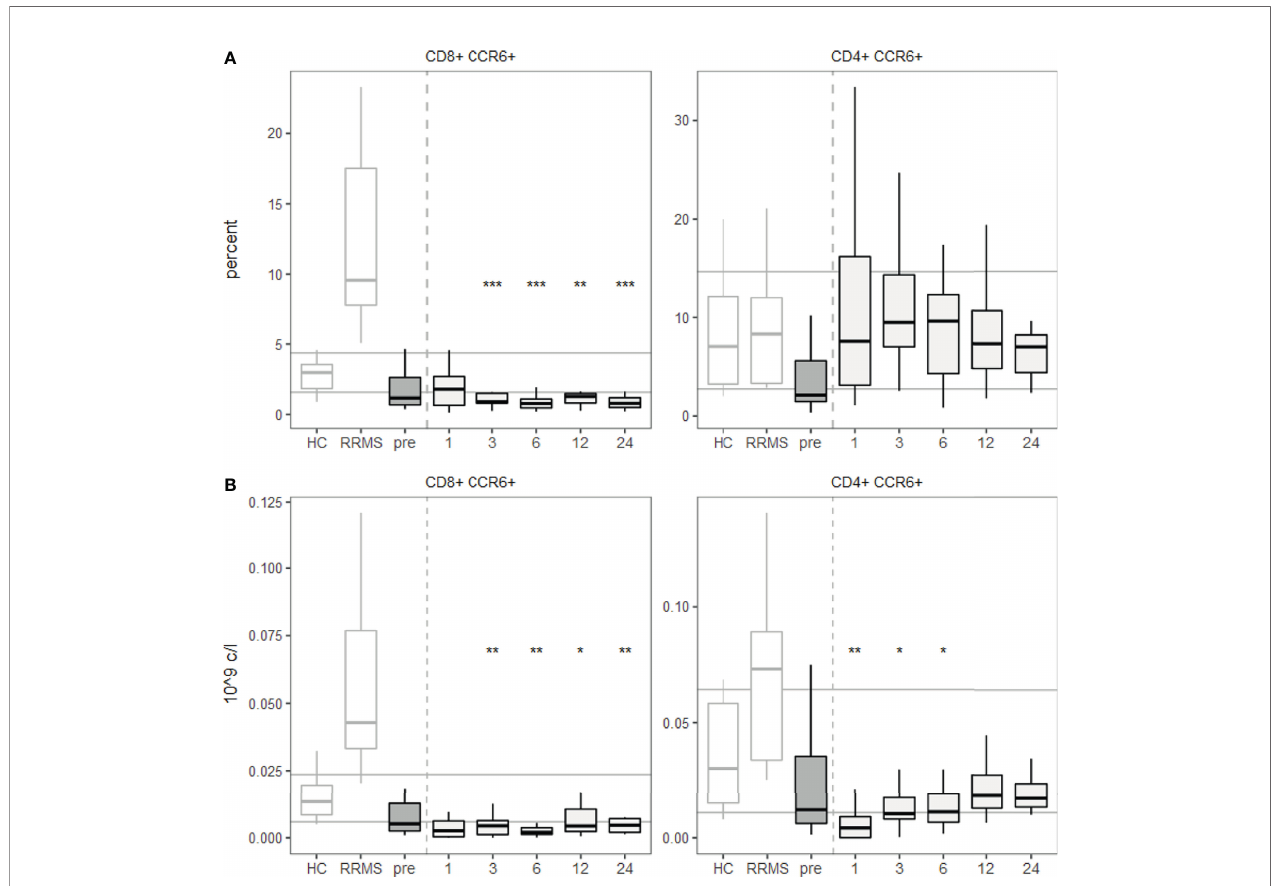
FIGURE 5 | A lower percentage of CD8+ T cells express CCR6 from 3 months post aHSCT onwards. PBMCs were stained with fl uorophore-conjugated surface antibodies and analyzed by fl ow cytometry. (A) Percentages are fractions of CD8+ (left) or CD4+ (right) T cells respectively. (B) Absolute number of CD8+ CCR6+ T cells (left) and CD4+ CCR6+ T cells (right). Number of samples were pre = 26, M1 = 21, M3 = 19, M6 = 27, M12 = 25, M24 = 11, HC = 12, RRMS = 10. As a global test, ANOVA was used, and in case of signi fi cance followed by pairwise comparisons (pre vs 1, 3, 6 and 12 months) using